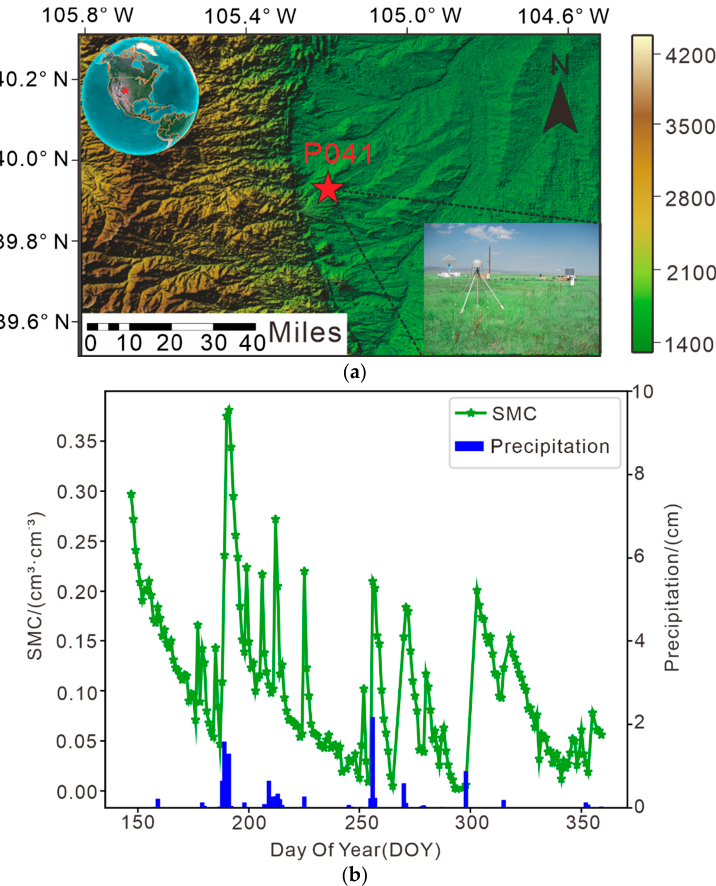
Figure 2. ( a ) The digital elevation model diagram of the experimental site, ( b ) The soil moisture- rainfall diagram during the experimental period.